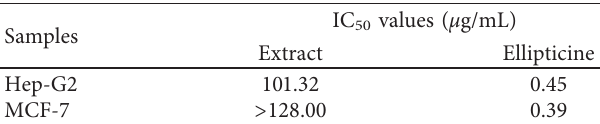
Figure 12: DPPH radical scavenging activity of the Table 4: IC 50 values of extract.